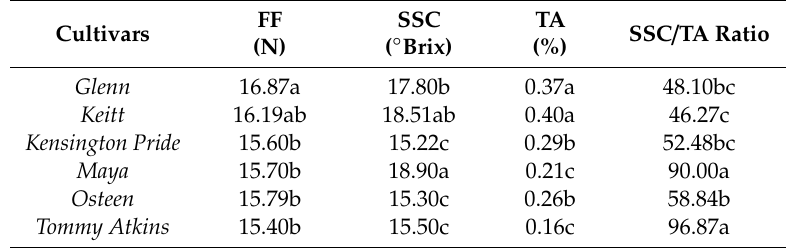
Table 3. Physicochemical parameters of the six mango cultivars in trial. Flesh firmness (FF); total soluble solid content (SSC); titratable acidity